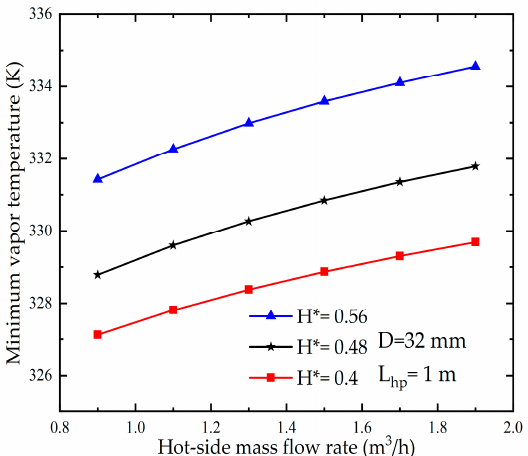
* H . (The mass flow rates